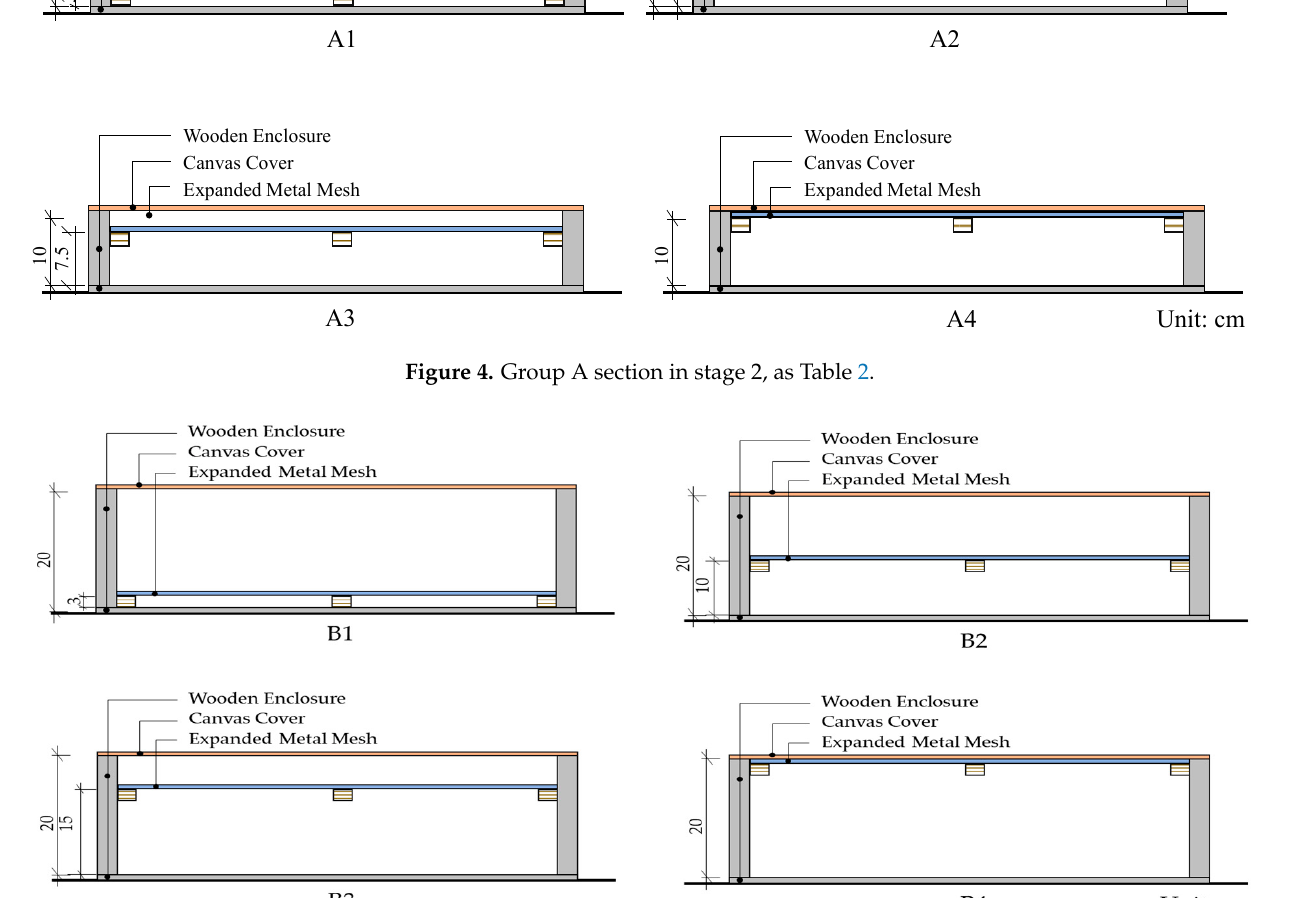
Figure 5. Group B section in stage 2, as table 2.